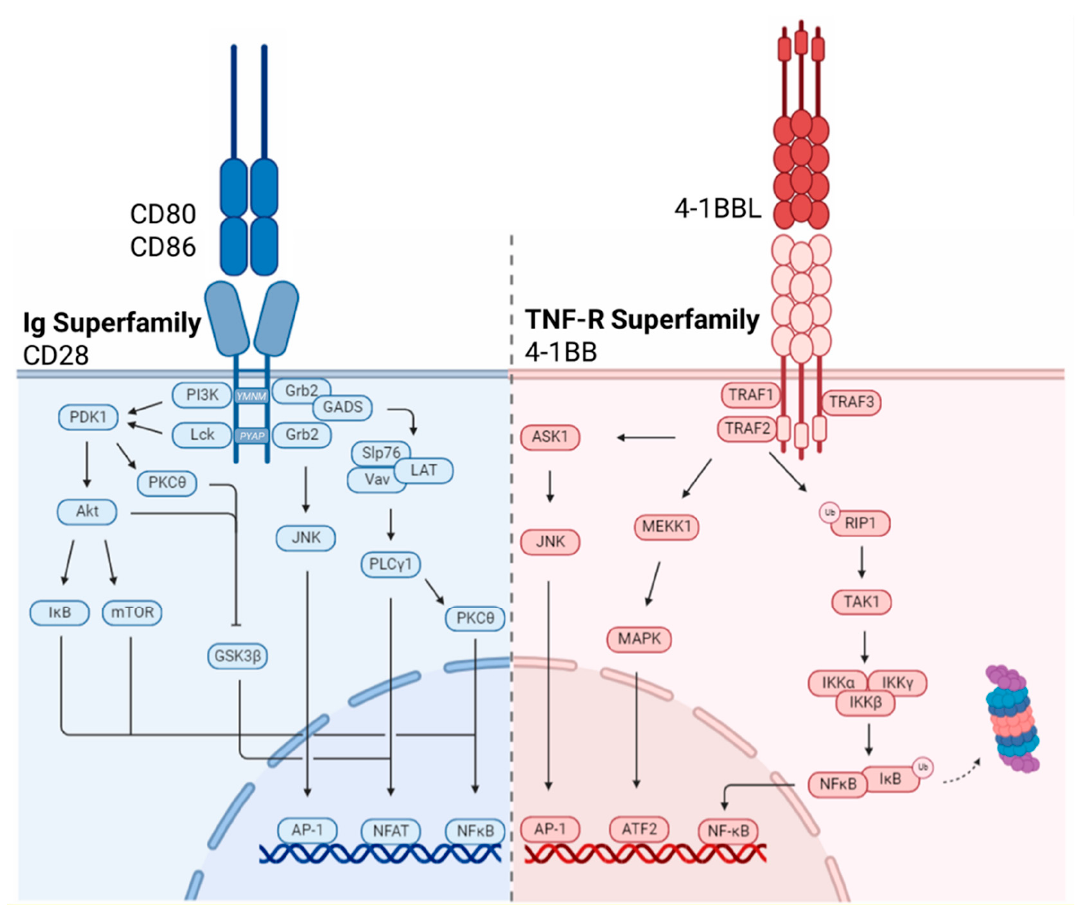
Figure 2. Co-stimulatory signaling pathways of the Immunoglobulin and TNF-R superfamilies. CD28 binds to B7 family members CD80 and CD86. Interaction with these ligands initiates the recruitment of adaptor molecules including PI3K, Lck and Grb2. PI3K and Lck activate PDK1 which diverges to activate both canonical NF- κ B through Akt activation and NFAT through GSK3 β inhibition. The binding of Grb2/GADS initiates the SLP76/LAT/Vav complex formation which activates PLC γ 1 leading to NFAT-dependent gene transcription. PLC γ 1 also activates PKC θ , which regulates activation of NF- κ B. Grb2 can also localize independently at the distal motif to mediate MAPK and JNK activation, promoting nuclear translocation of the AP-1 complex. 4-1BB binds to its sole ligand 4-1BBL, which induces the recruitment of TRAF molecules. TRAF2 mediates RIP1 ubiquitination leading to the recruitment of TAK1 and activation of the IKK complex. IKK activation promotes the ubiquitin-mediated proteasomal degradation of I κ B, releasing NF- κ B subunits from an inhibitory state. Independent of NF- κ B signaling, TRAF2 also activates upstream MAPK, MEKK1 and ASK-1, which initiate the p38 MAPK signaling cascade and the JNK/SAPK pathway, respectively. Transcriptional activity induced by both Ig and TNF-R signaling induce anti-apoptotic signals, T cell proliferation and cytokine production